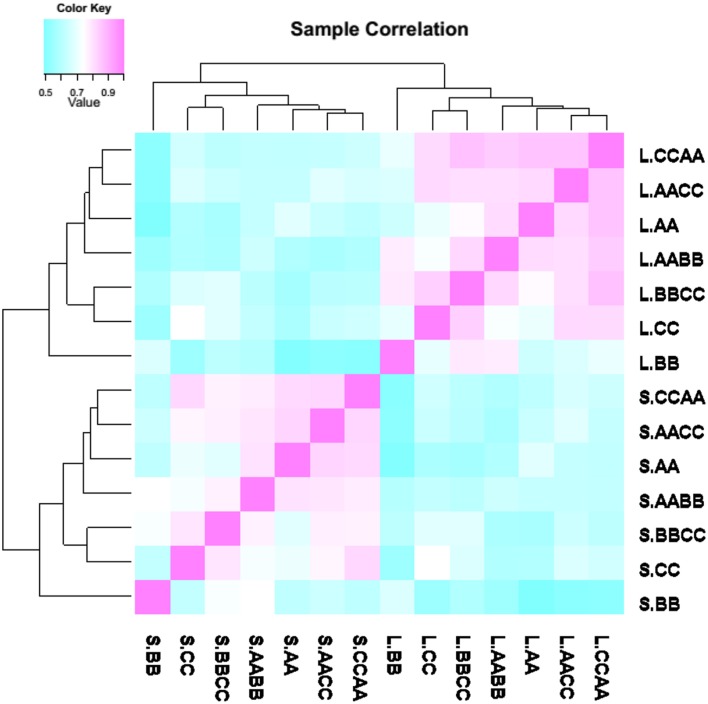
Gene expression correlations between nascent allotetraploids and parents. The branch length represents the extent of gene expression variance among samples.